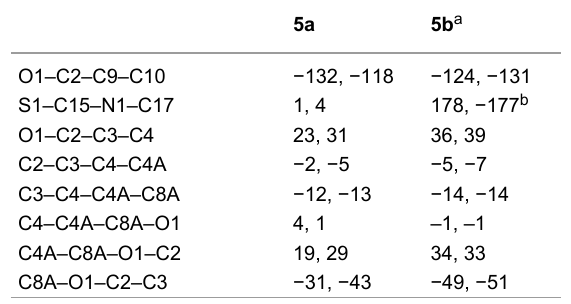
Table 4: Selected torsion angles (°, rounded to nearest degree) for 5a and 5b